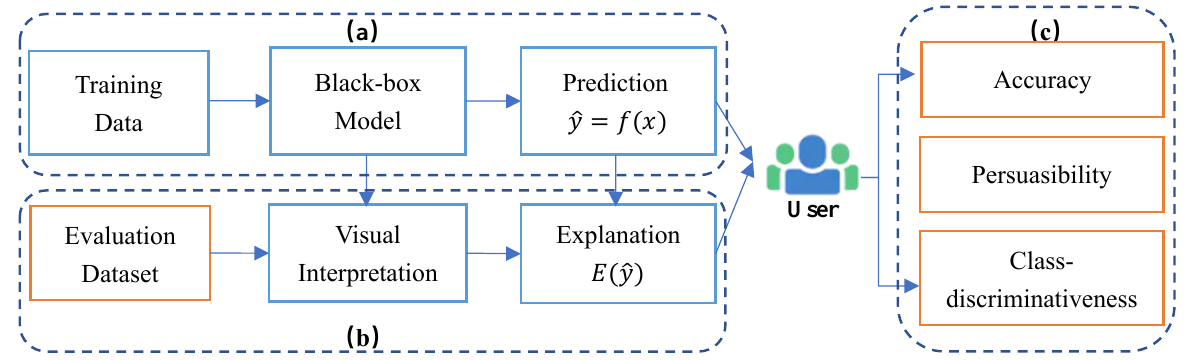
Figure 2. Overview of our evaluation framework, which contains three parts model decision process ( a ), generating interpretation process ( b ) and user-oriented evaluation process ( c ) (Note that the blue box represents the existing research results, the orange box is our innovative